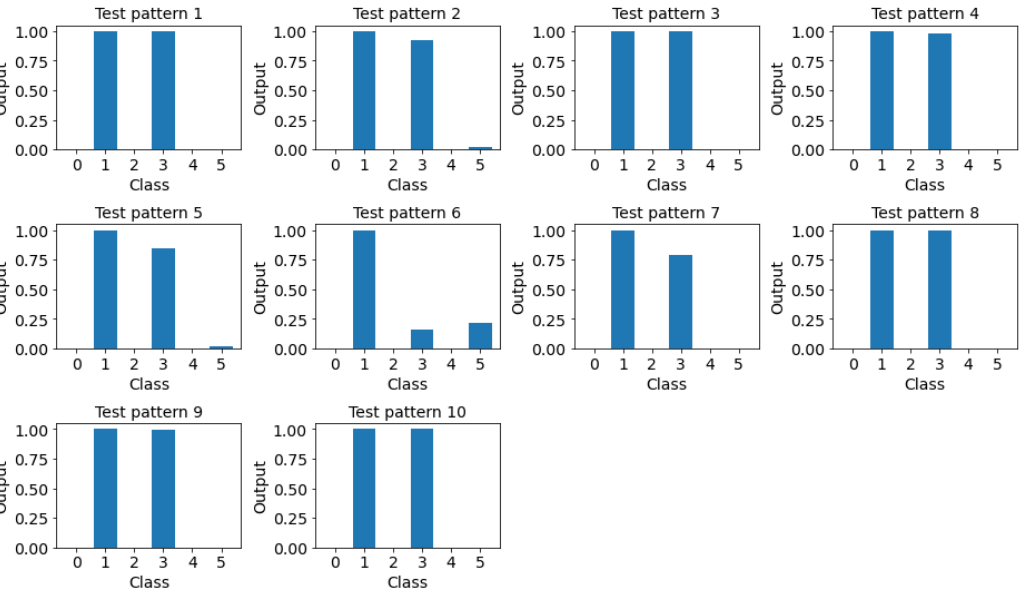
Figure 10. The results of the multi-label 1D CNN.